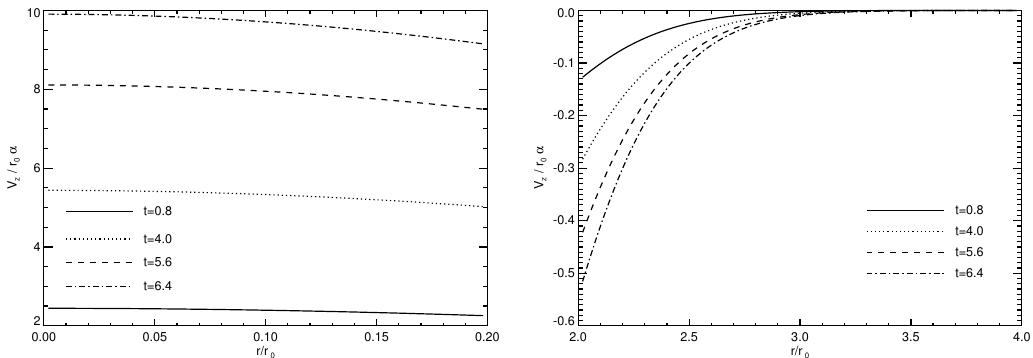
Figure 2. The normalized vertical velocity (V z /r 0 α) for z = 2 r 0 as a function of r/r 0 and time t = 0 . 8, 4.0, 5.6, and 6.4s. The r/r 0 intervals are the same as for Fig.